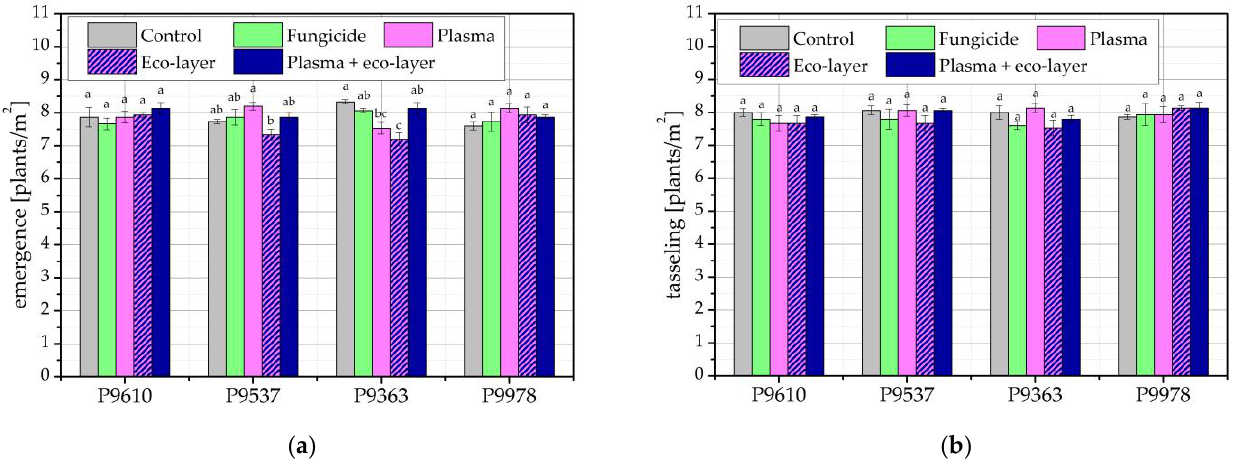
Figure 3. Number of maize plants in two vegetative growth stages of maize in the harvest year 2021: ( a ) at seedling emergence; and ( b ) at tasseling time. The error bars represent standard error. Different lowercase letters above data points represent statistically significant differences ( p < 0.05; post hoc Tukey’s range test) between treatments.